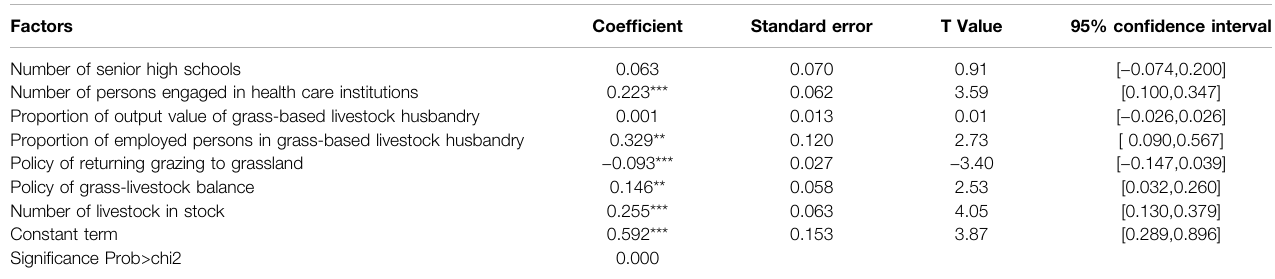
TABLE 5 | Regression results of Tobit model.